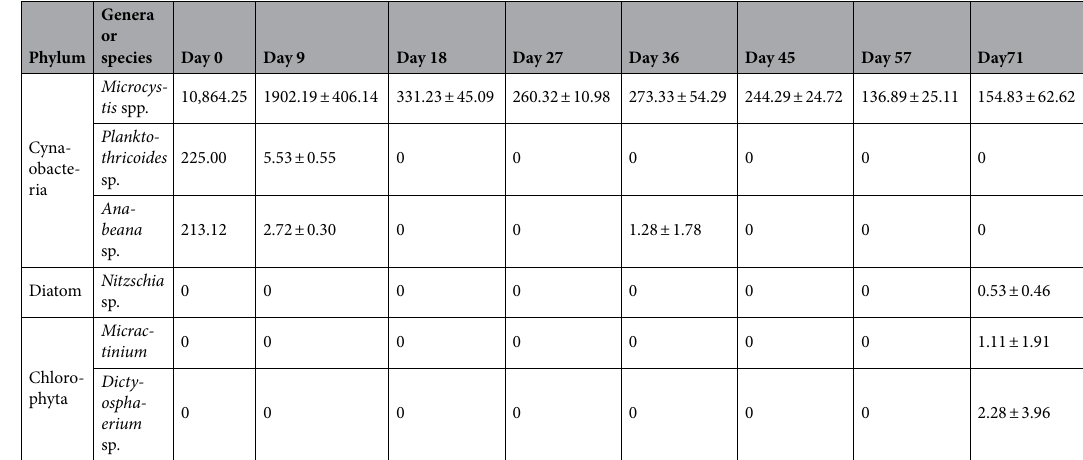
Table 5. Algal changes in the five dominant genera in treatment High (wet weight, mg L −1 ).